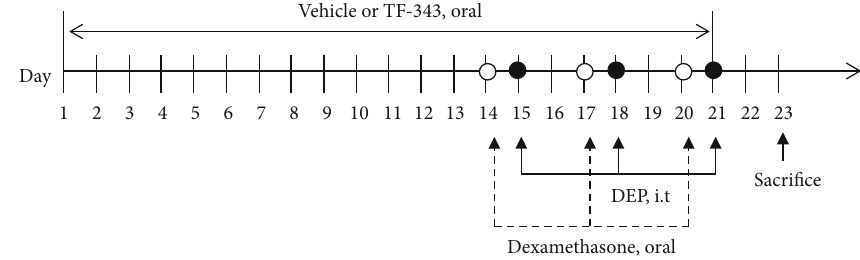
Figure 1: Diagram of in vivo experimental protocol. DEP: diesel exhaust particulate; i.t: intratracheal